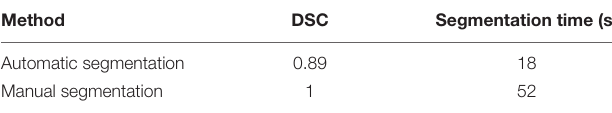
TABLE 2 | Comparison with different segment masks.